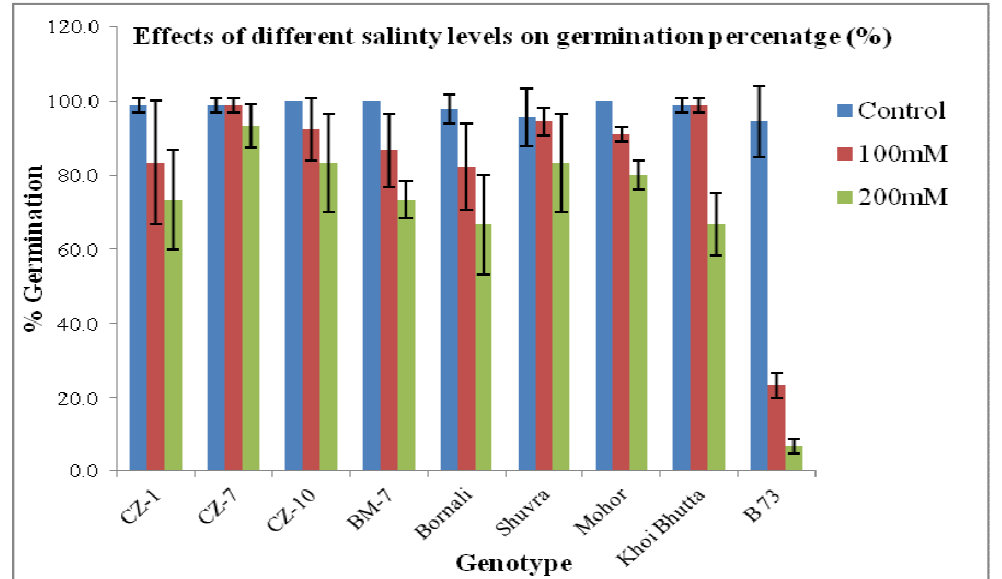
Fig. 1. Effects of different salinity levels on germination percentage